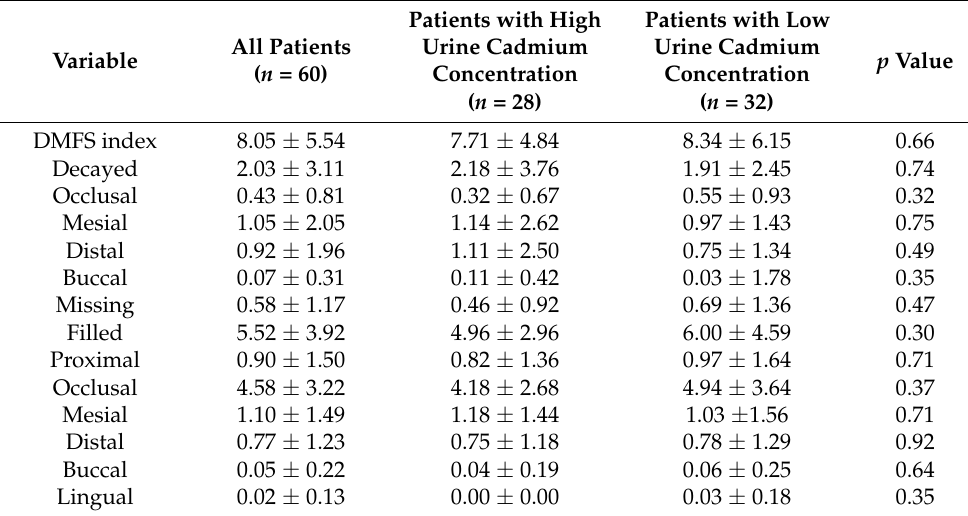
Table 4. Decayed, missing, and filled surface (DMFS) index of orthodontic patients, stratified according to their urine cadmium concentrations as high or low ( n =